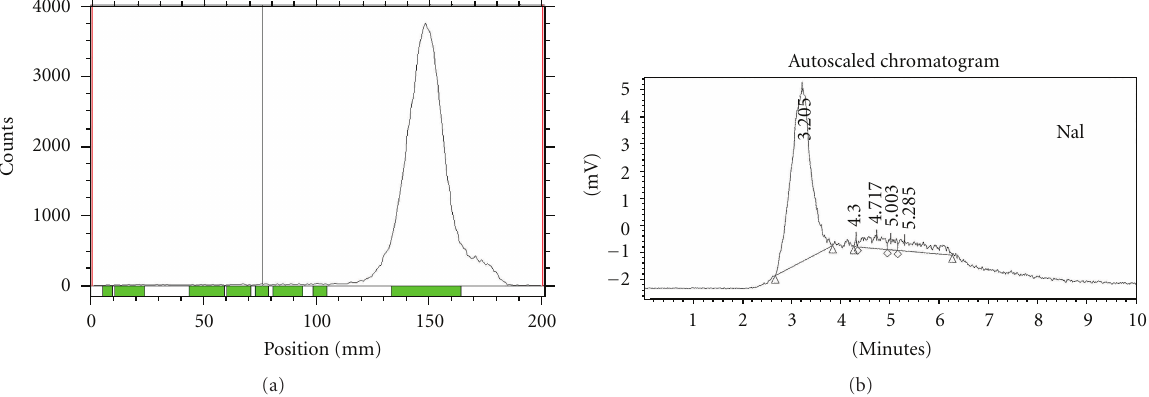
Figure 4: ITLC (a, in saline) and HPLC (b, NaI detector) analysis of 99m Tc-ECG (mobile phase: H 2 O/acetonitrile, 9 :1 V/V, flow rate: 0.5mL/min, Column: C18-extend (Agilent), UV ABS: 210 nm). Radio-TLC and HPLC analyses of the purity of 99m Tc-ECG were >